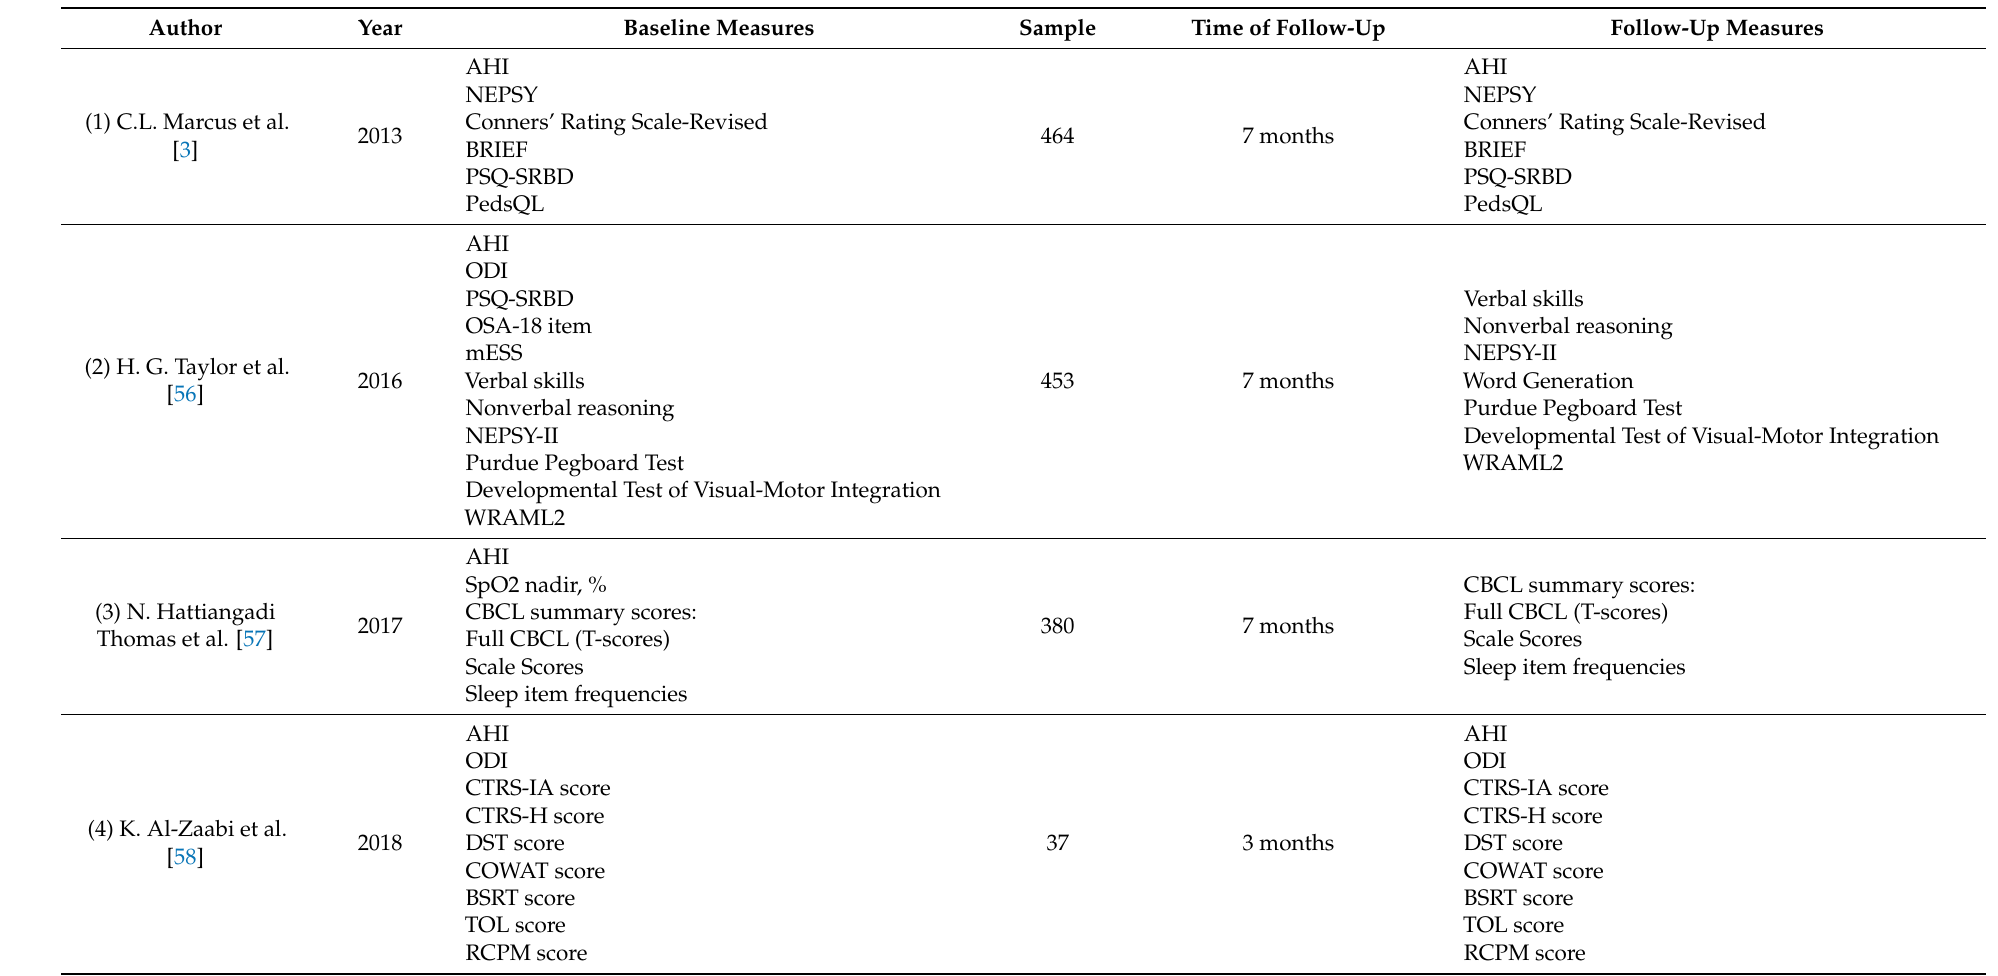
Table 2. Studies measured both at baseline and follow